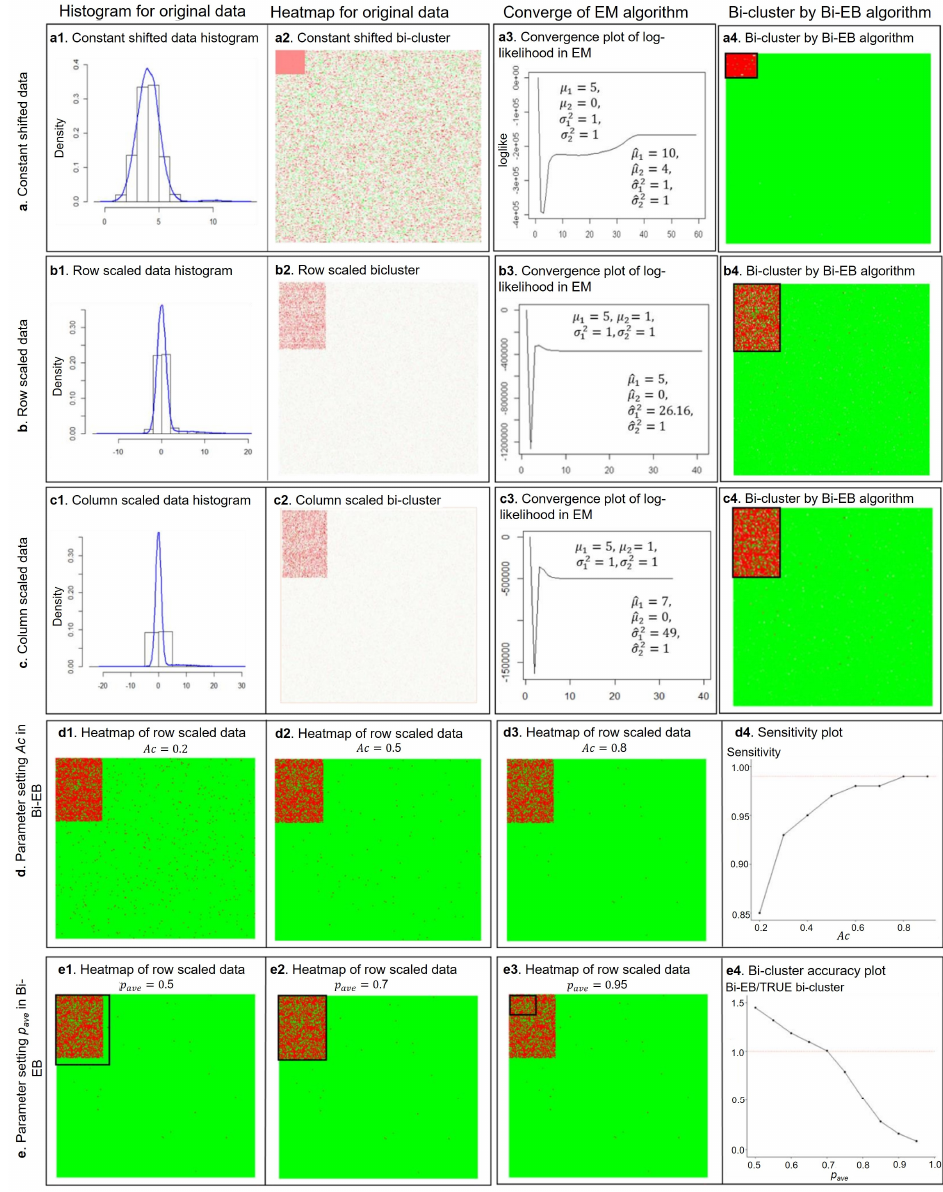
Figure 2. A Bi-EB algorithm for the bicluster on three simulation datasets. ( a ) The Bi-EB algorithm is tested for the constant-shifted bicluster pattern. ( a1 , a2 ) displays a histogram plot and heatmap of the original constant shift bicluster data; ( a3 ) plots the log-likelihood convergence in the EM procedure of Bi-EB in iteration; ( a4 ) displays the extracted bicluster from background using the Bi-EB algorithm. ( b ) The Bi-EB algorithm is tested on a row-scaled bicluster pattern. ( c ) The Bi-EB algorithm is tested on column - scaled bicluster data. ( b1 – c4 ) have the same description as in ( a ). ( d ) The